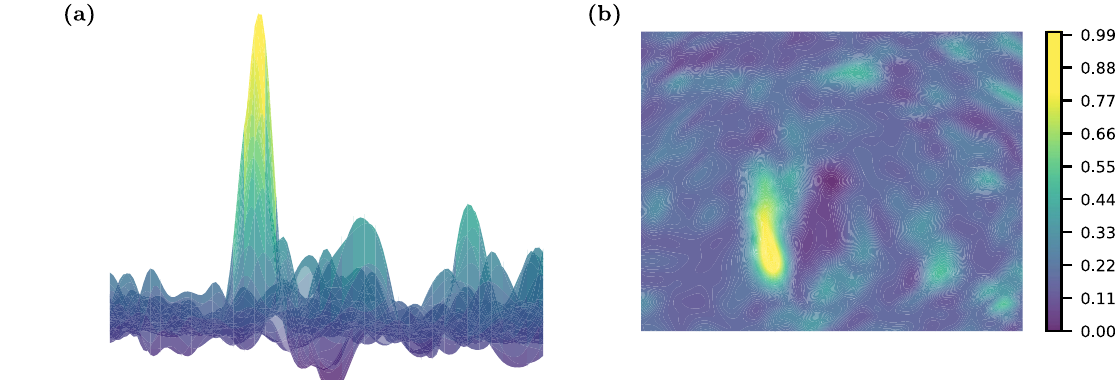
learning task of the QCNN for 14 qubits. Though a global minimum is located at the center of the plot, fi nding this global minima is generally challenging due to the shape of the loss landscape. Details of this visualization are given in Supple- mentary Note